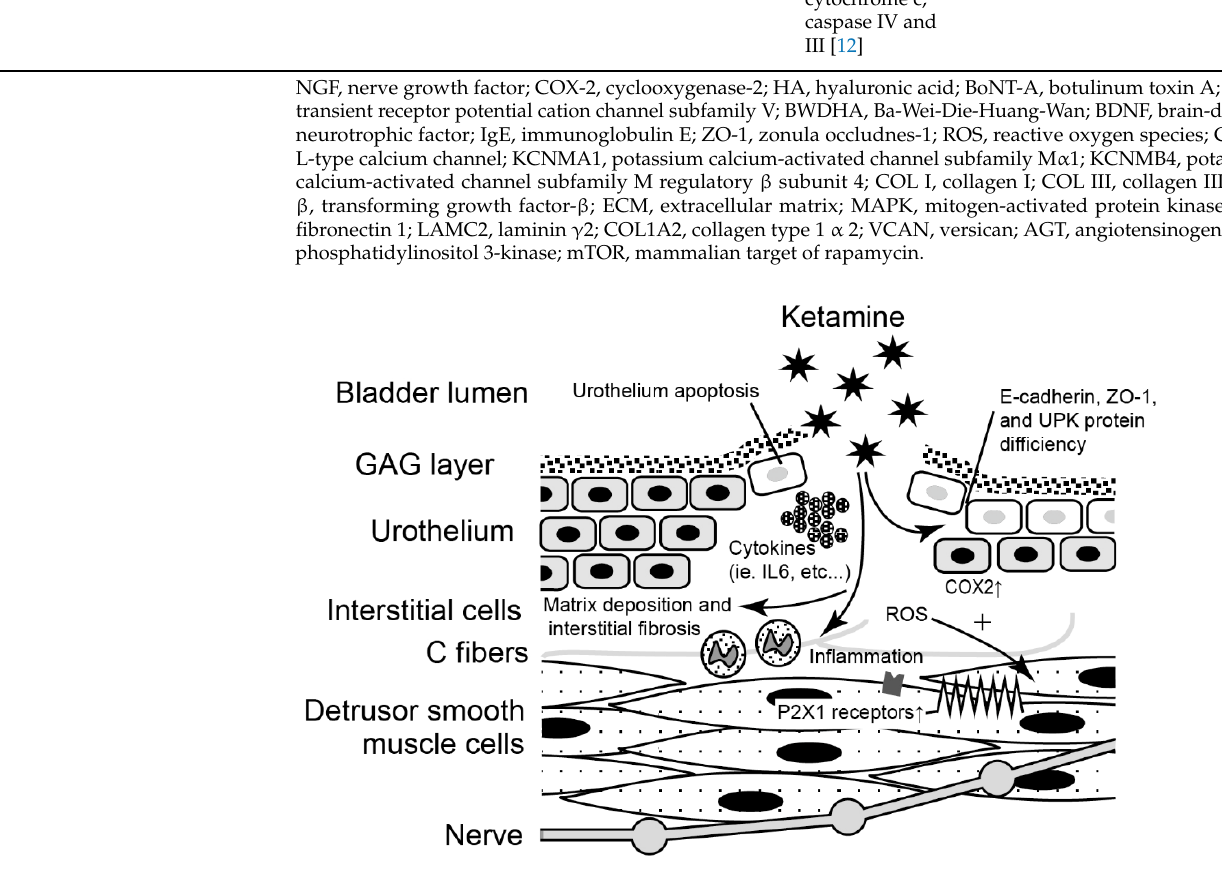
Figure 2. Schematic of possible mechanisms of ketamine-related cystitis, contains activation of inflammatory cells, dysfunction of bladder-urothelial barrier, dysregulation of neurotransmission, cell apoptosis, and oxidative stress. ROS: reactive oxygen species, ZO-1: zonula occludens-1, UPK: uroplakins, COX2: cyclooxygenase-2. Table 1. Possible molecular etiology and potential targeted treatment of KC based on human, an- imal, and in vitro studies.